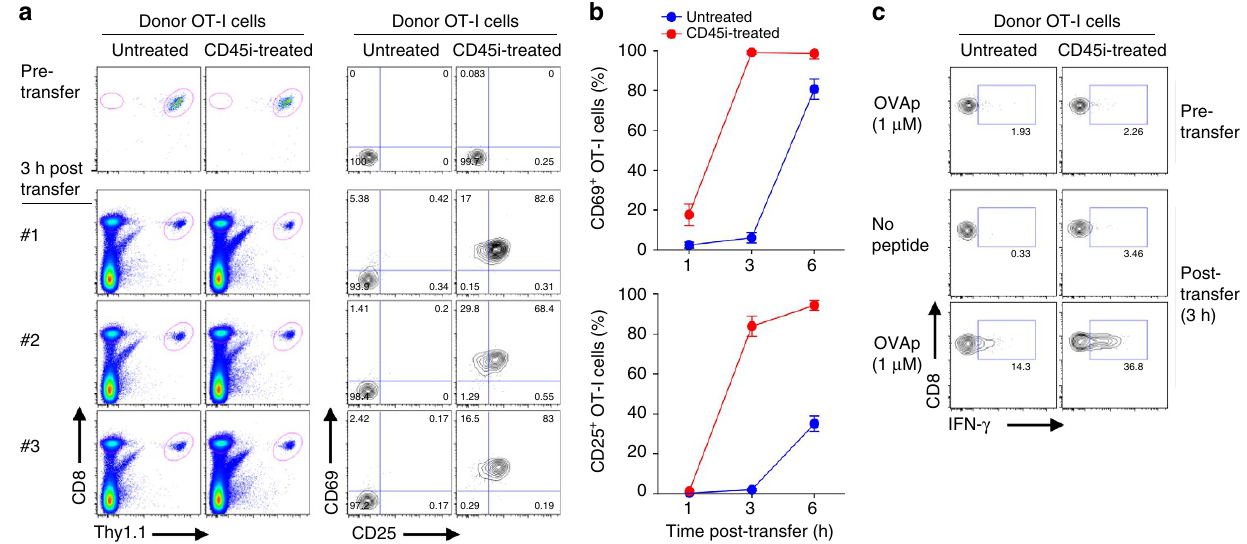
Figure 8 | Effects of CD45 inhibition on TCR sensitivity to foreign antigen. ( a ) Naı¨ve OT-I CD8 þ T cells (Thy1.1) either untreated or pretreated with CD45i (5 m M) for 30min in vitro were injected i.v. into B6 mice ( n ¼ 3) that had been preinjected i.p. with OVAp (5 m g) plus polyI:C (10 m g) 2h before adoptive transfer. At 3h after transfer, spleens were collected and analysed by flow cytometry for expression of early activation markers, CD69 and CD25, on donor OT-I cells. ( b ) Mice as in a were analysed at 3 and 6h after adoptive transfer for percentage of donor OT-I cells expressing CD25 or CD69 (means ± s.d.). ( c ) Spleen cells collected at 3h after transfer as in a were cultured in vitro with or without OVAp for 5h and analysed by flow cytometry for intracellular IFN- g production. Data are representative of two independent experiments ( a – c